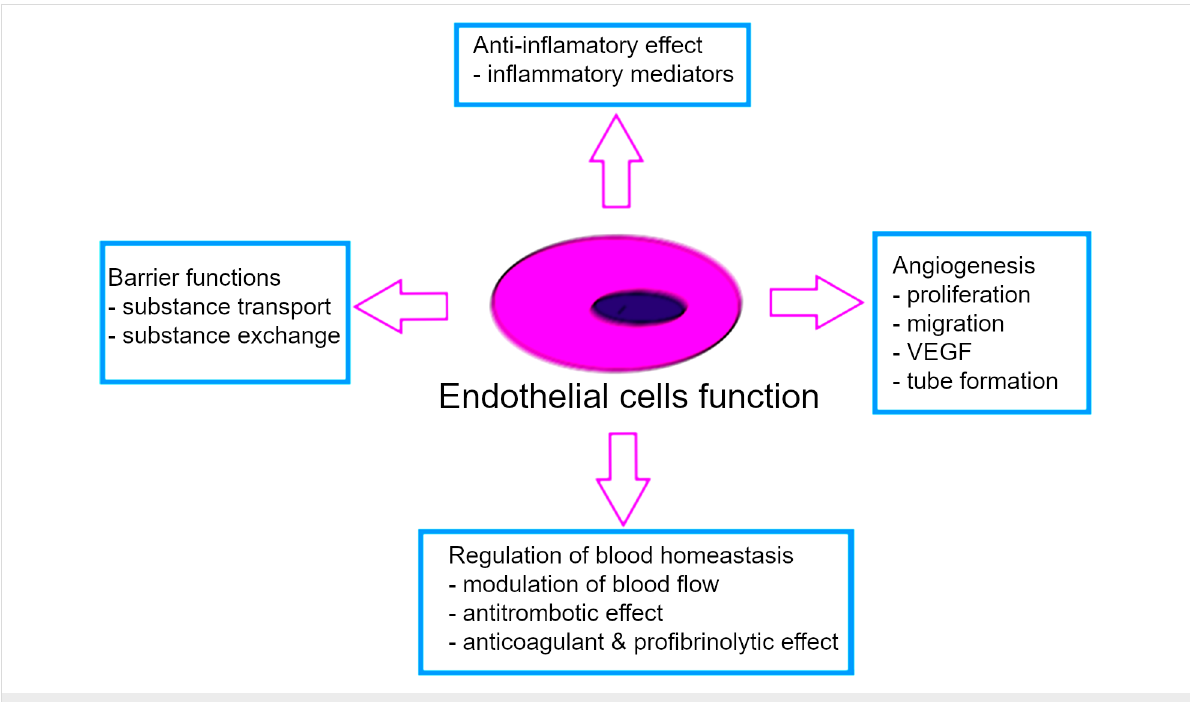
Figure 1: The main functions of endothelial